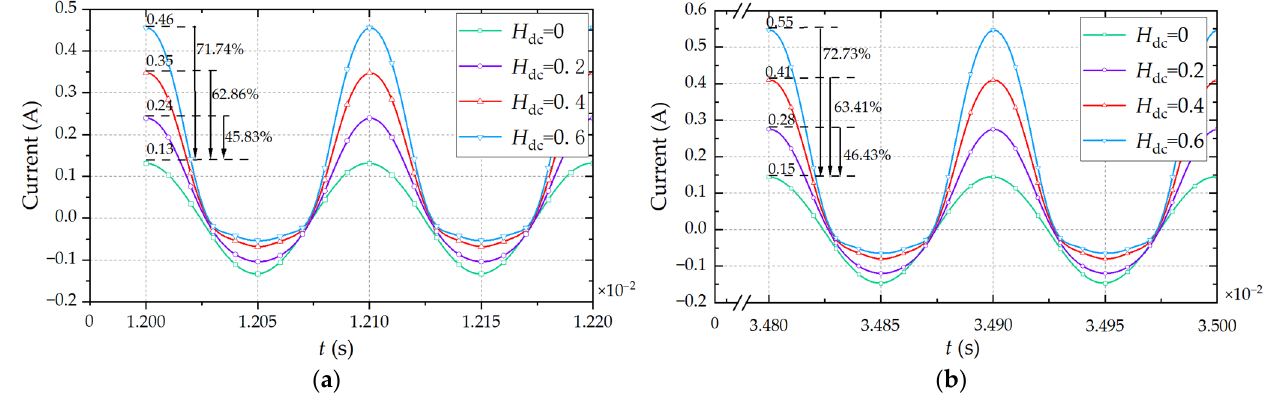
Figure 9. Schematic diagram of excitation current under different DC bias coefficients. ( a ) Interleaved windings; ( b ) Continuous windings.